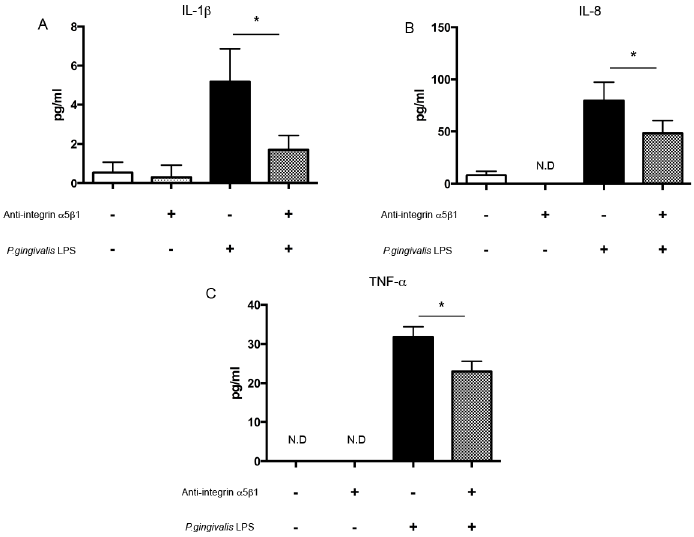
Fig 6. Inflammatory cytokines are downregulated by blocking integrin α 5 β 1. (A) IL-1 β , (B) IL-8, and (C) TNF- α protein levels in Ca9-22 cells pretreatedwith anti-integrin α 5 β 1IgG and then stimulated with P . gingivalis LPS for 24 h. Differencesamonggroups were analyzedusing one-wayANOVA. Data are expressedas means ± SD ( n = 4). * p < 0.05 vs. control. ND: not detectable.